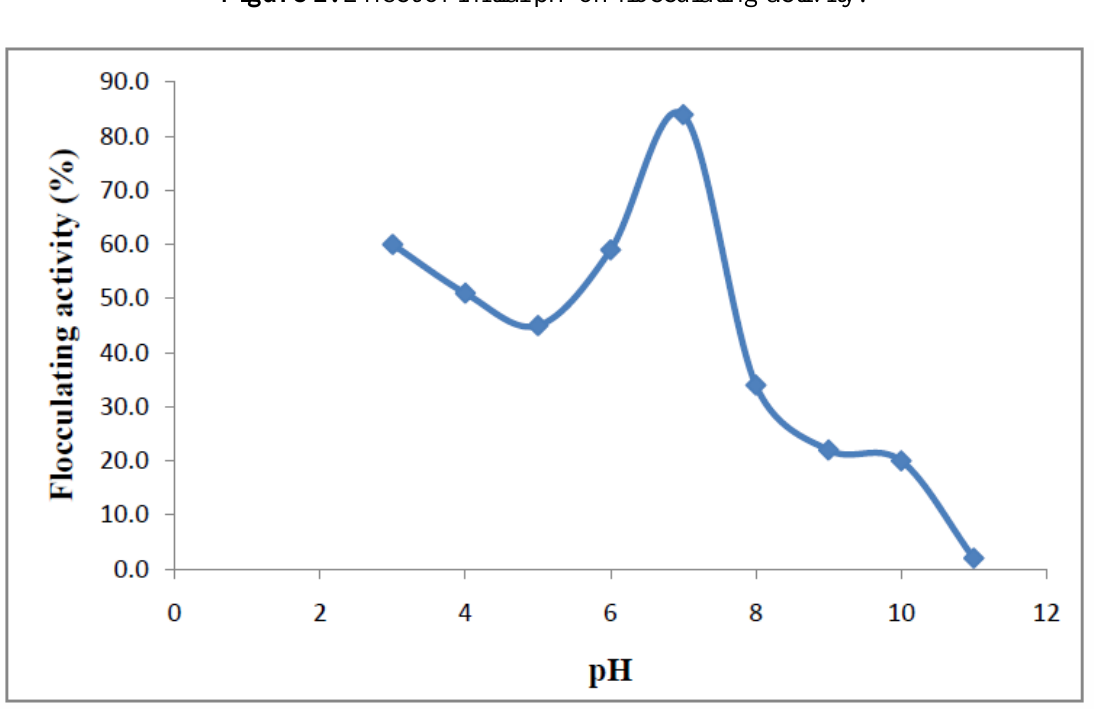
Figure 2. Effect of initial pH on flocculating